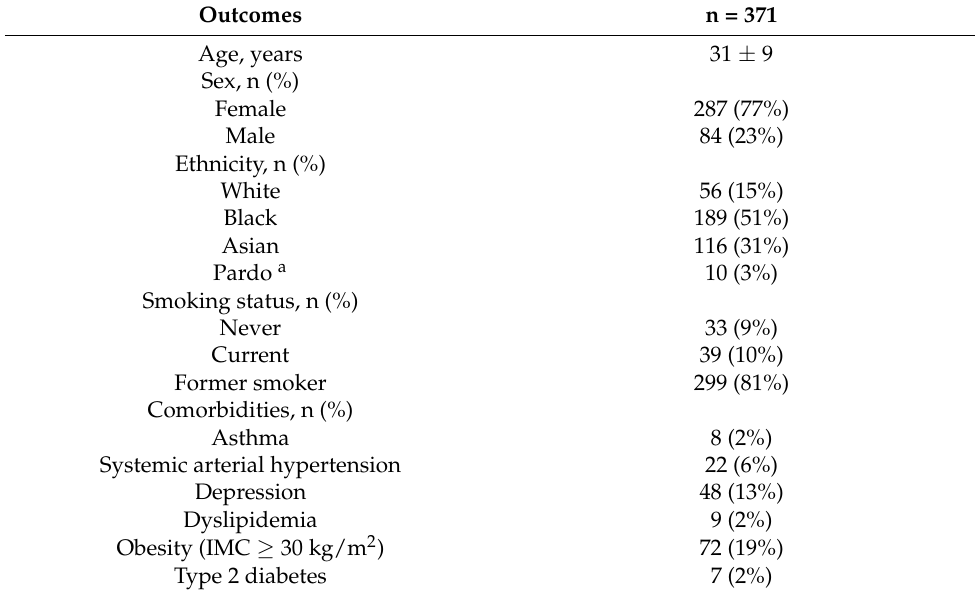
Figure 1. Relative frequency of respondents from each course. Table 1. Characteristics of the